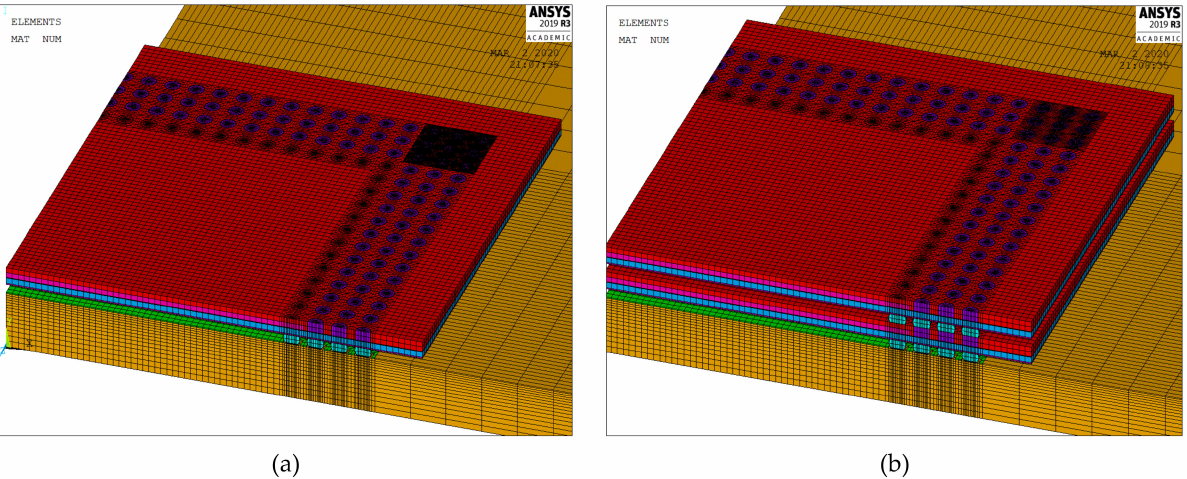
Figure 10. Three-dimensional MPC-reduced finite element models for the ( a ) FO-WLP and ( b ) FO-WLP